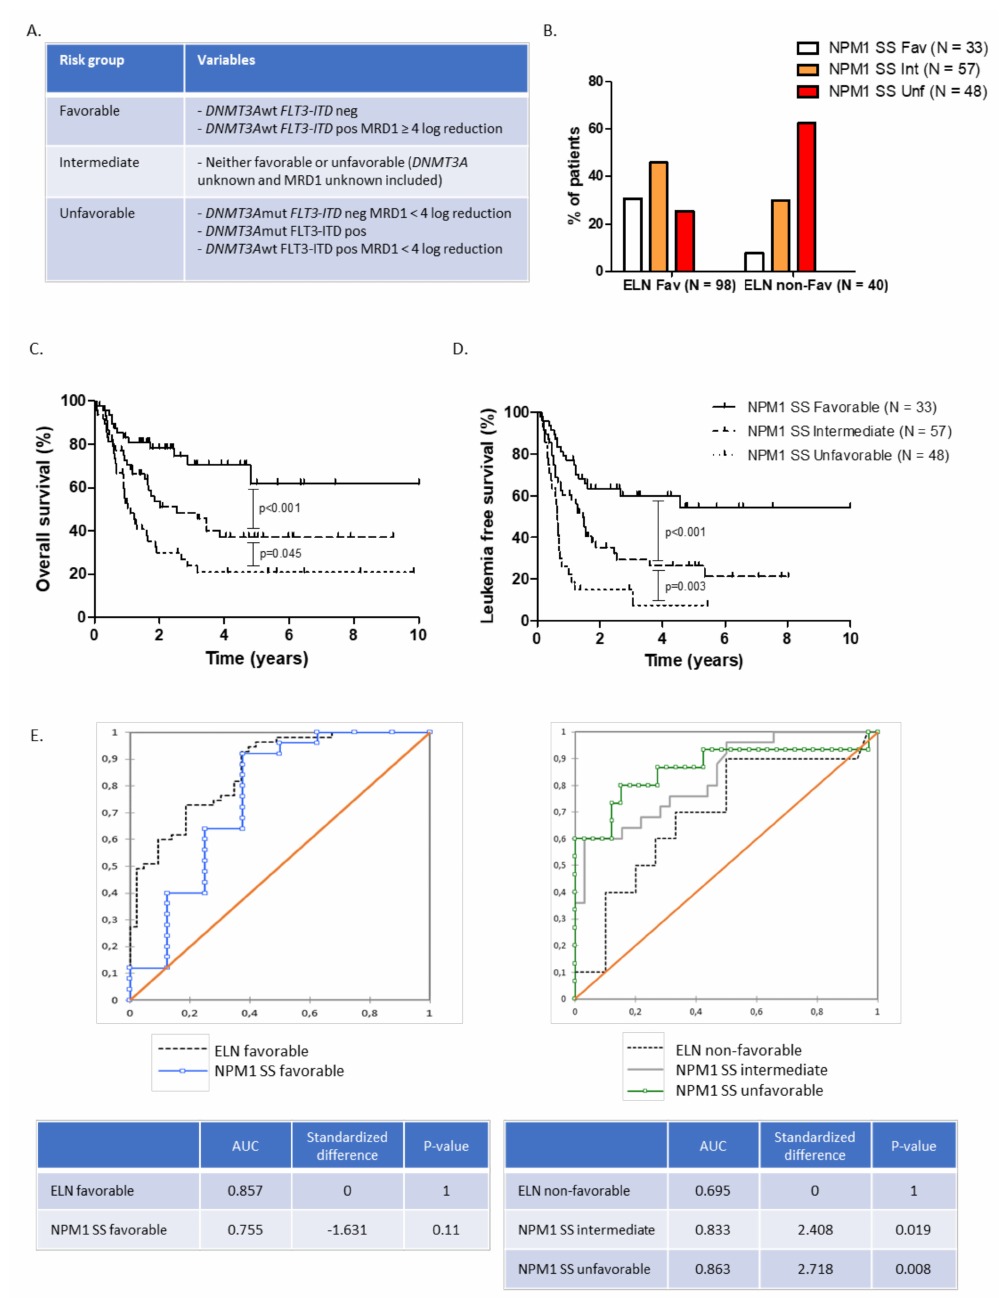
Figure 3. ( A ) NPM1 scoring system (SS) risk groups, ( B ) ELN 2017 risk groups reallocation according to NPM1 SS, ( C ) overall survival, and ( D ) leukemia-free survival in NPM1 SS favorable, intermediate, and unfavorable risk groups. ( E ) ROC curve analysis assessing overall survival prediction according to ELN and NPM1